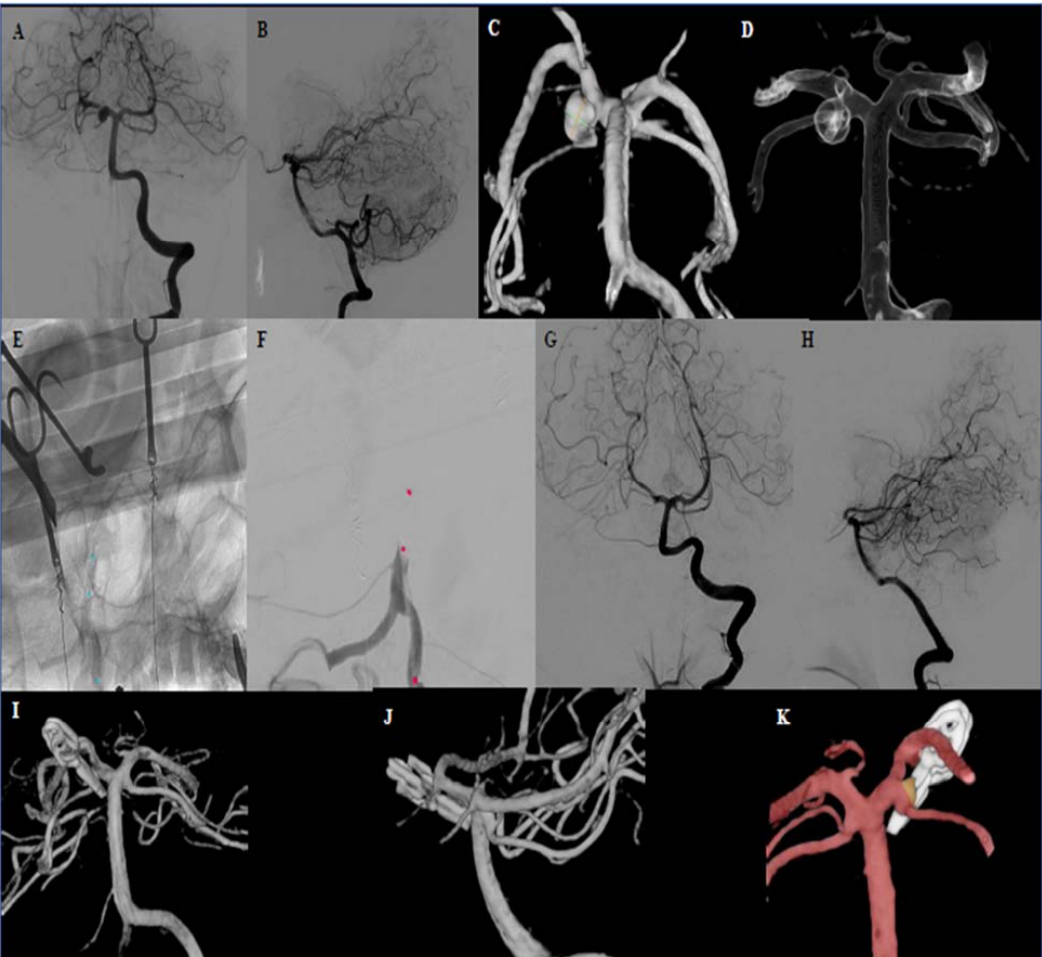
Figure 3. Case 3. Preoperative DSA ap and lateral projections of the proximal right side PCA aneurysm (P1 branch) ( A , B ). Preoperative 3D-DSA of the PCA aneurysm, showing the right SCA leaving